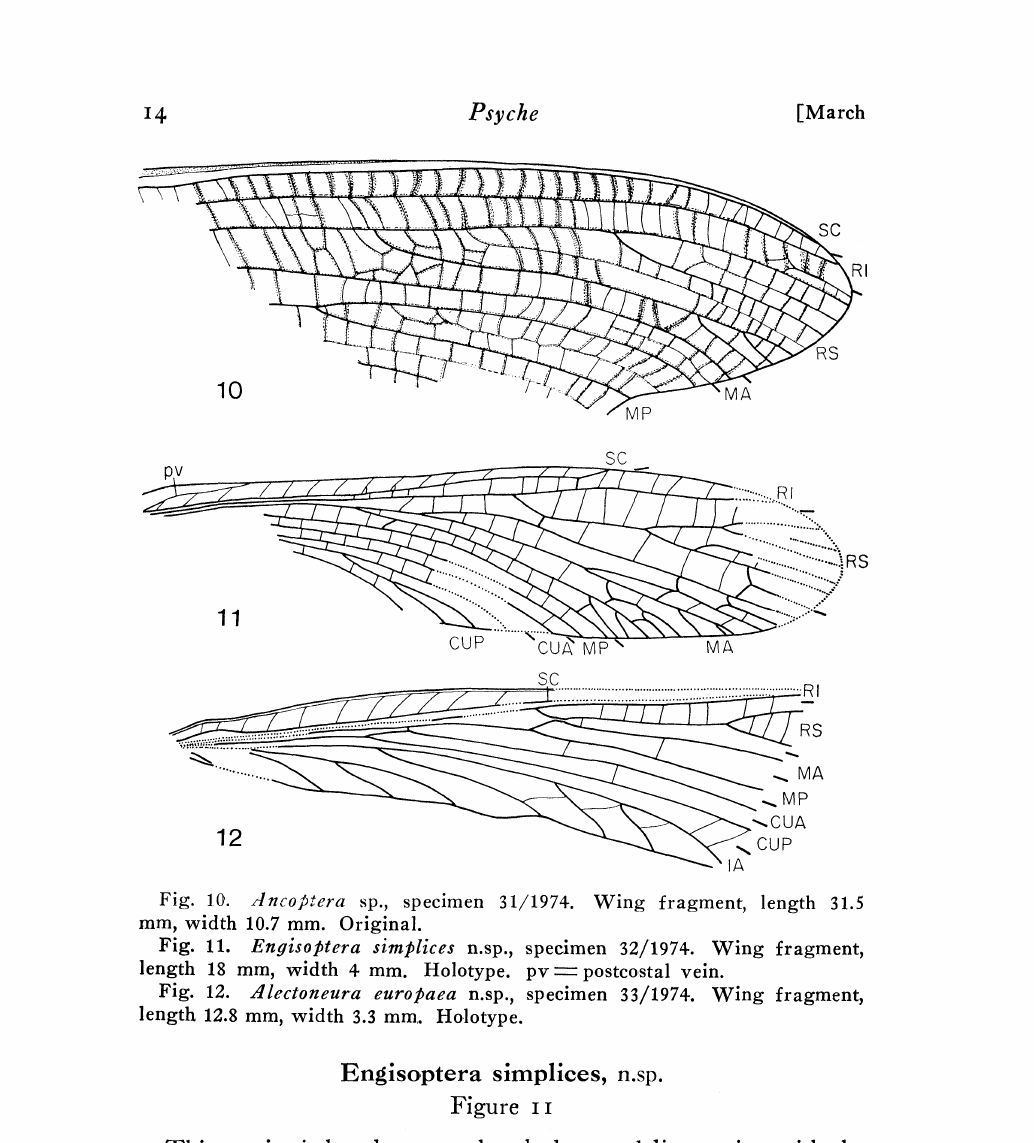
Fig. 1.0. Ancoptera sp., specimen 31/1974. Wing fragment, length 31.5 mm, width 10.7 mm. Original. Fig. 11. E’nlisoltera simlices n.sp., specimen 32/1974. Wing fragment, length 18 mm, width 4 mm. Holotype. pv--posteostal vein. Fig. 12. dlectoneura europaea n.sp., specimen 33/1974. Wing fragment, length 12.8 mm, width 3.3 mm. Holotype. Engisoptera simpliees,